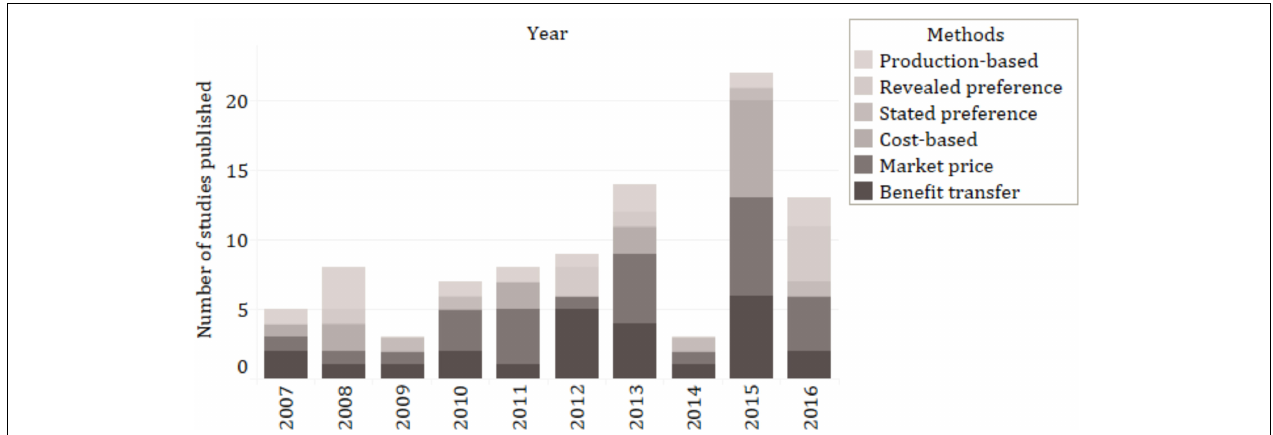
FIGURE 2 | Use of valuation methods between 2007 and 2016. Methods are categorized as follows: cost-based methods include avoided cost, conversion cost, damage cost, mitigation cost, opportunity cost, replacement cost, and restoration cost. Stated preference methods include choice modeling, contingent ranking, contingent valuation, and participatory valuation. Revealed preference methods include consumer surplus, hedonic pricing, marginal abatement price for carbon, net price method, public investments, social cost of carbon, substitute goods, and travel cost method. Production-based methods include bio-economic modeling, analysis, and production